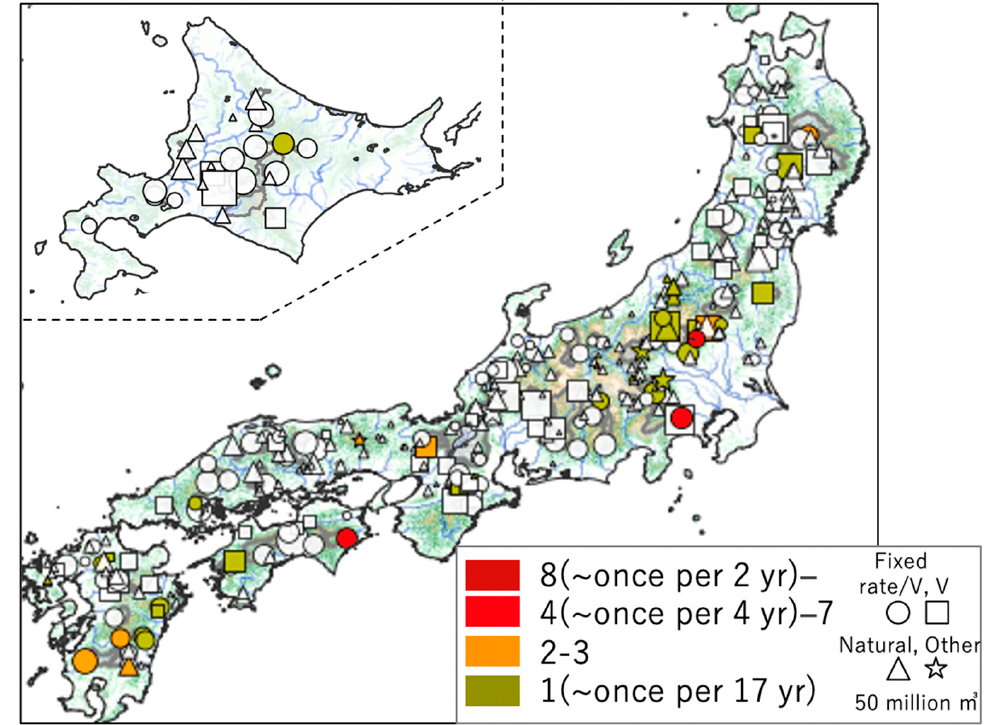
Figure 13. Number of pre-release cases for each reservoir on a map.